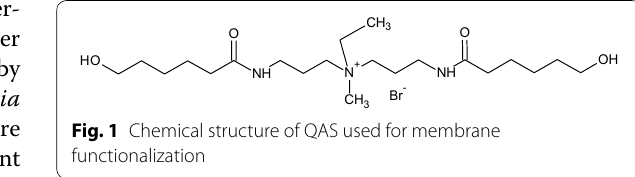
the nitrogen from the linker and silver. The diameter of the generated particles was approximately 20 nm. Final